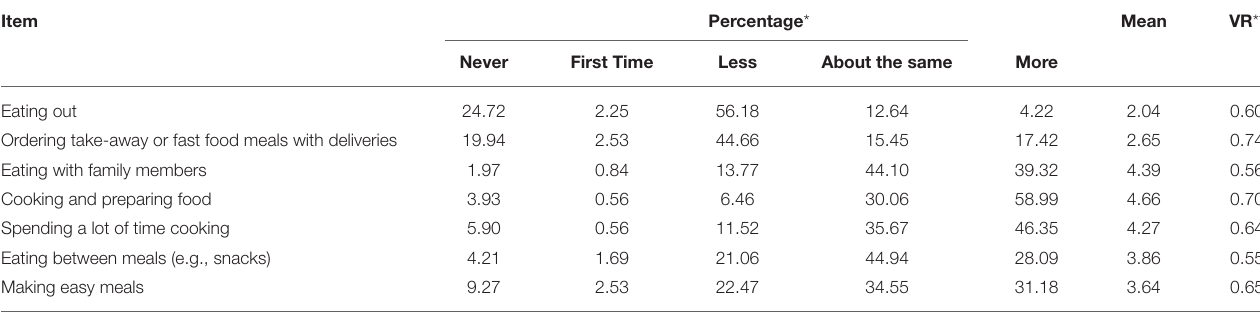
TABLE 4 | Change of food-related activities during the COVID-19 pandemic ( n = 356). Item Percentage * Mean